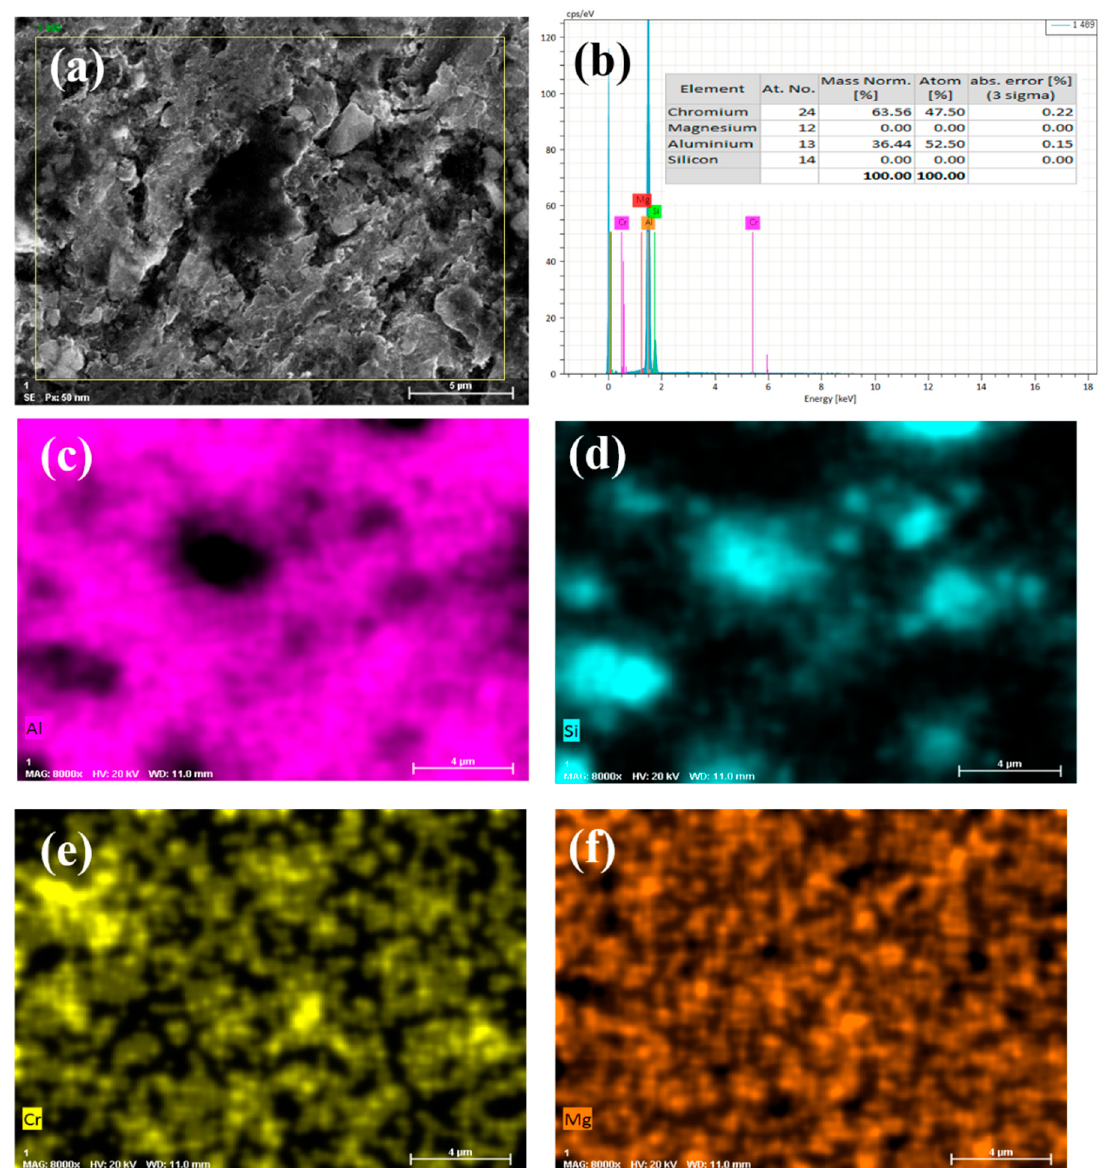
Figure 8. Microstructure and EDS mapping of Al-7%Si-0.3%Mg-0.3%Cr alloy after 30-days immersion, ( a ) 8000×, ( b ) EDS results, and corresponding EDS maps of elements ( c ) Al, ( d ) Si, ( e ) Cr, ( f ) Mg.